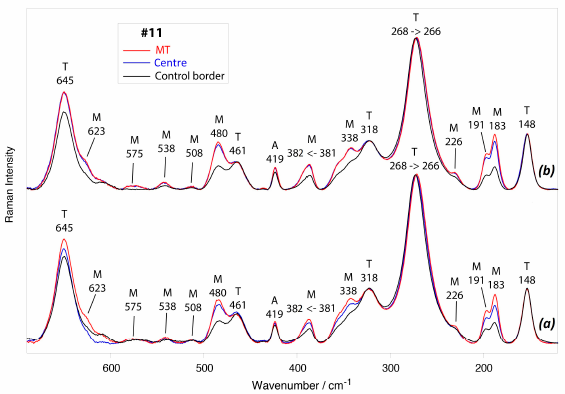
Figure 4. Average micro-Raman spectra recorded under optical conditions ( a ) and ( b ) in the border control area (black), near the centre of the articulating surface (blue), and in the MT area (red) of Biolox ® delta retrieval #11. The bands assignable to alumina (A), tetragonal (T), and monoclinic (M) zirconia are indicated.